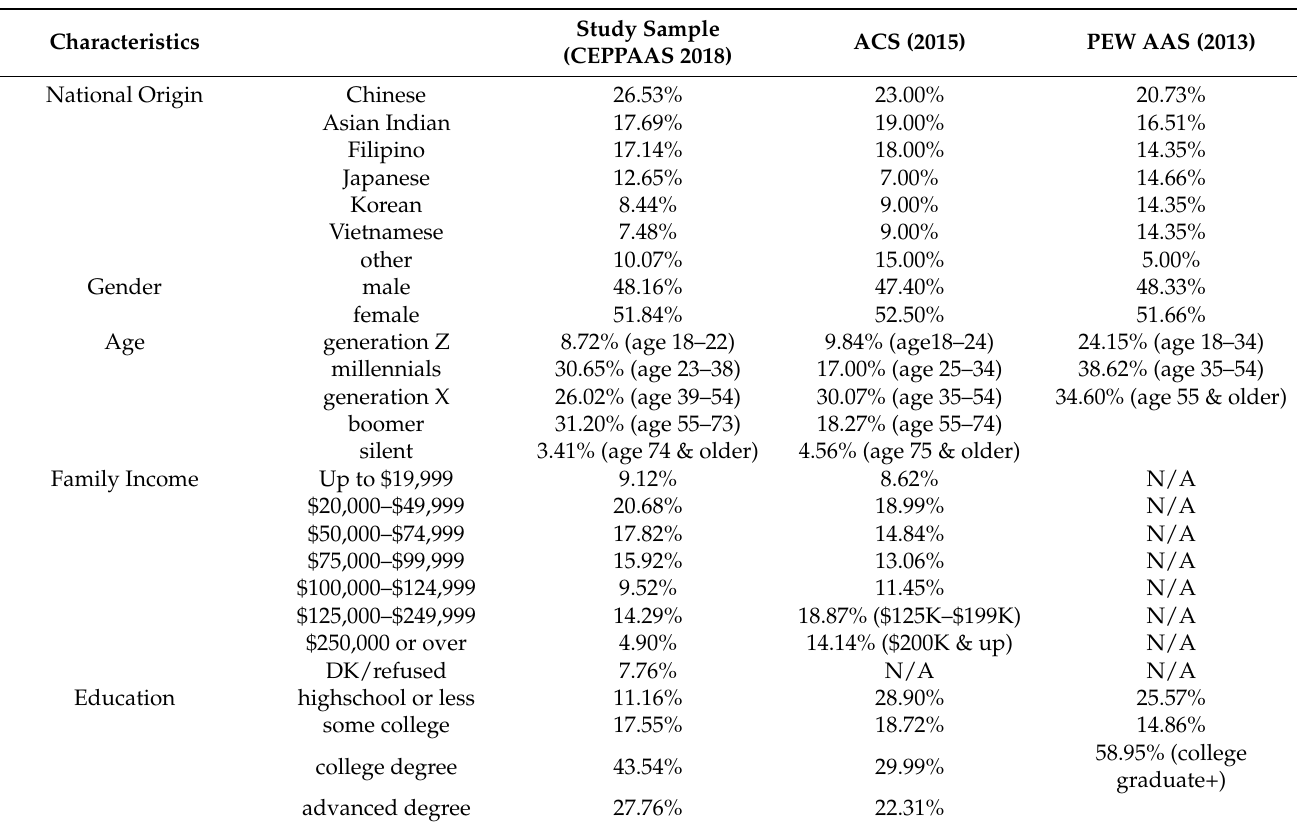
Table 1. Comparison of sample characteristics between CEPPAAS and the existing data. The Asian American survey from Pew Research Center was conducted in 2012, and the updated edition of survey reports was released in 2013. Differences in coding exist for age, generation, and education in three surveys. The information about family income is not available from Pew